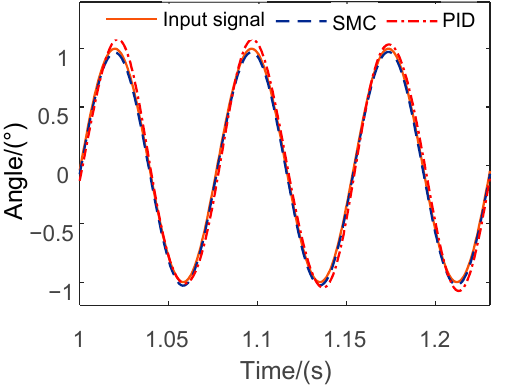
Figure 8. Dynamic response of the controller for a 13 Hz, 1° sinusoidal excitation.